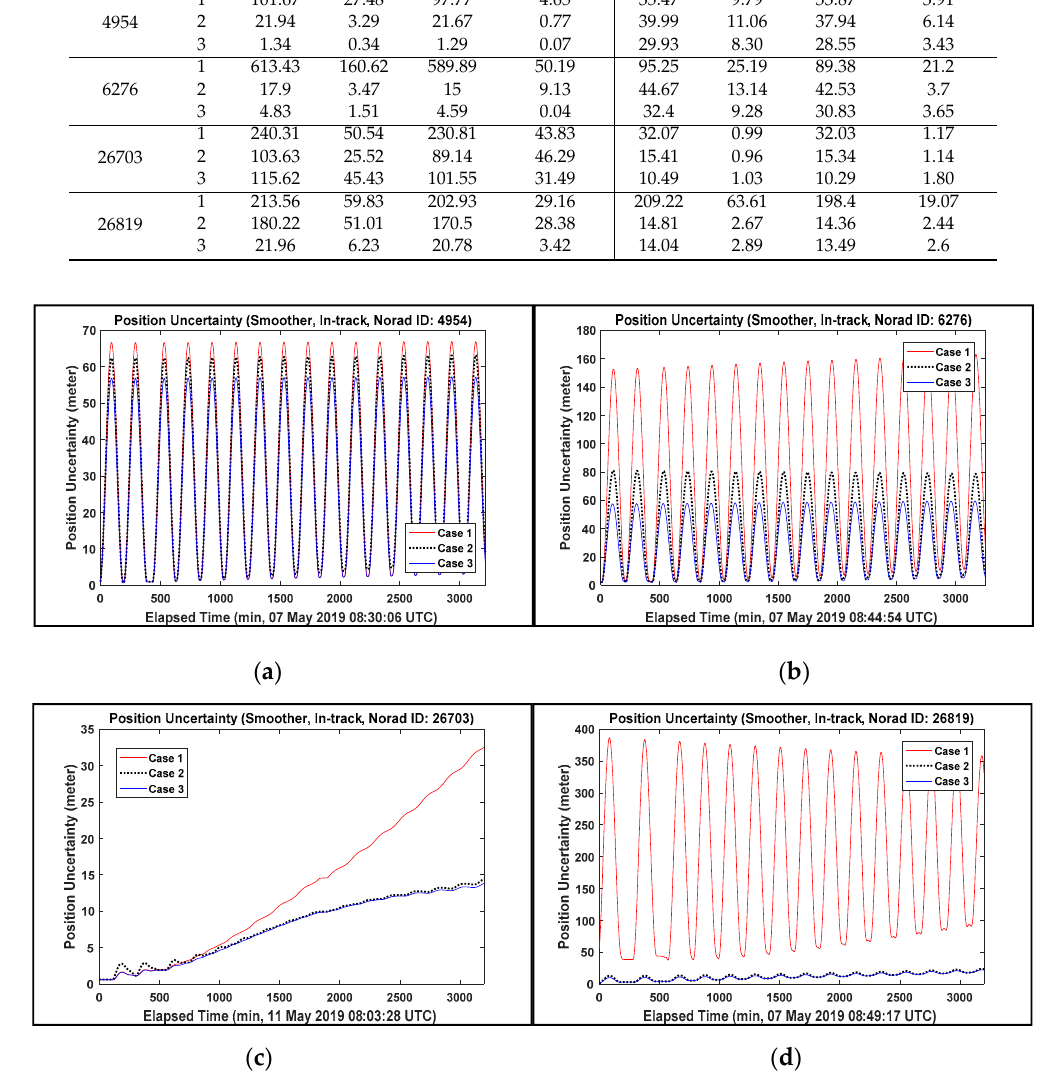
Figure 7. The position uncertainty of Case 1, 2 and 3. ( a ) ID 4954; ( b ) ID 6276; ( c ) ID 26703; ( d ) ID 26819.